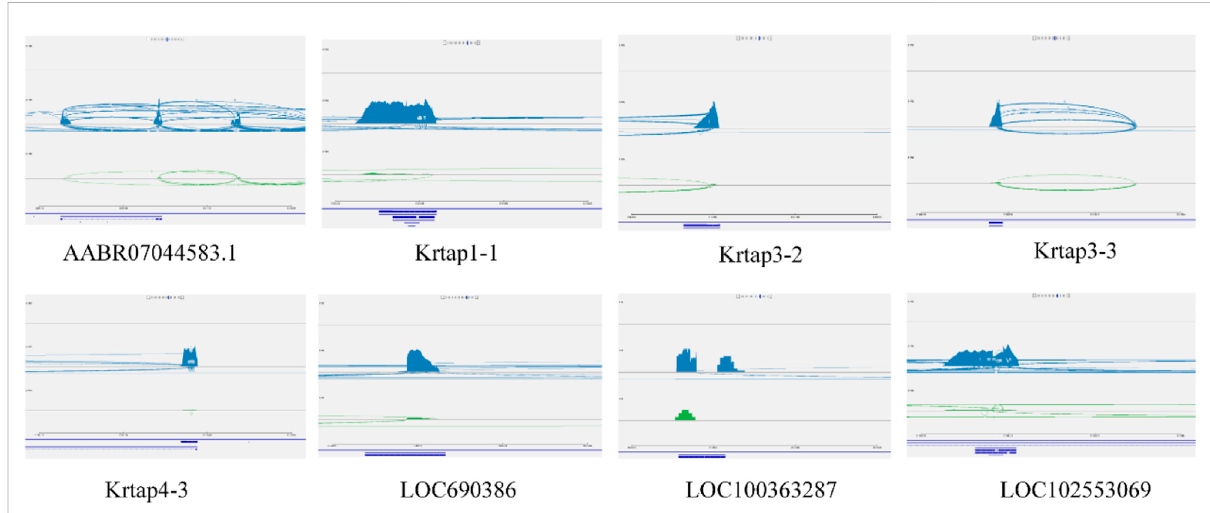
FIGURE 8 ThehighsulfurproteingenesexpressioninmoredetailbyIGV.Thehighsulfurproteingenewerenotexpressedinadultmalehomozygous( − / − ) skin tissue, the expression of high sulfur protein genes in the wild-type (+/+) Wistar rat skin was marked blue. The green node represent the expression of high sulfur protein genes in heterozygous (+/ − )